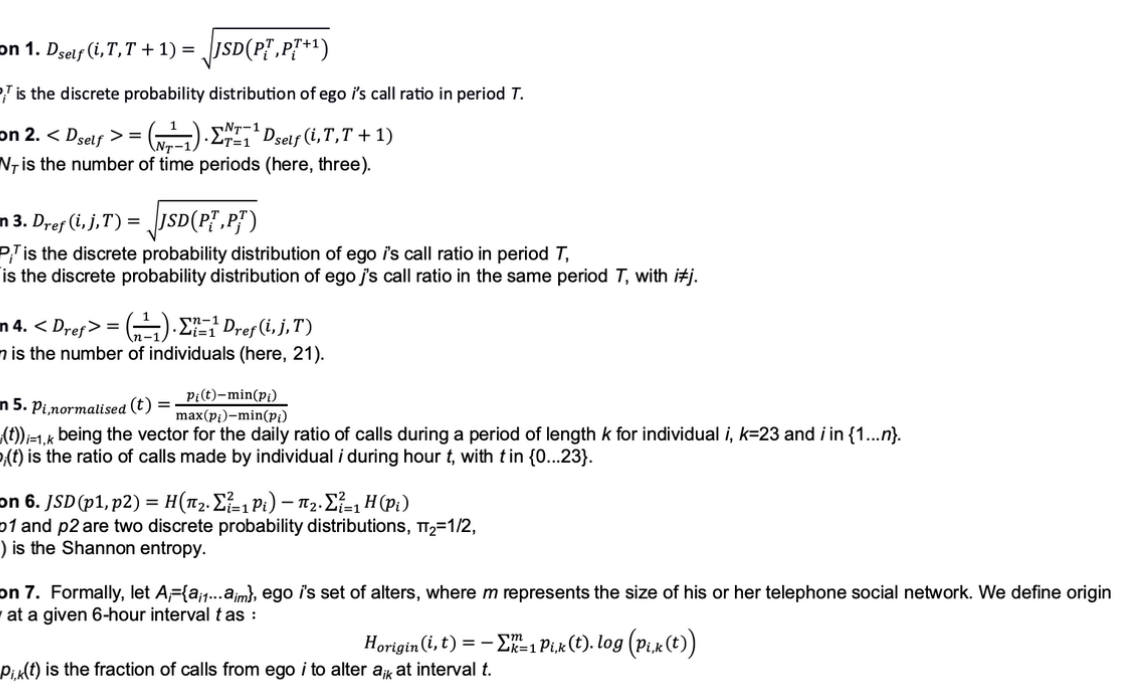
Figure 1. Equations used in the